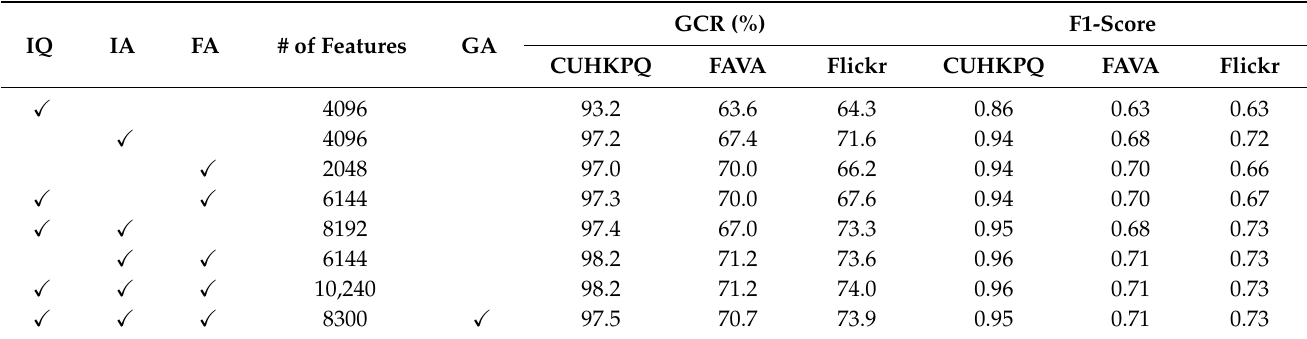
Table 1. Results for the aesthetic quality categorization for each database by extracting perceptual features from the whole image. FA, AFFACT; GCR, good classification rate.